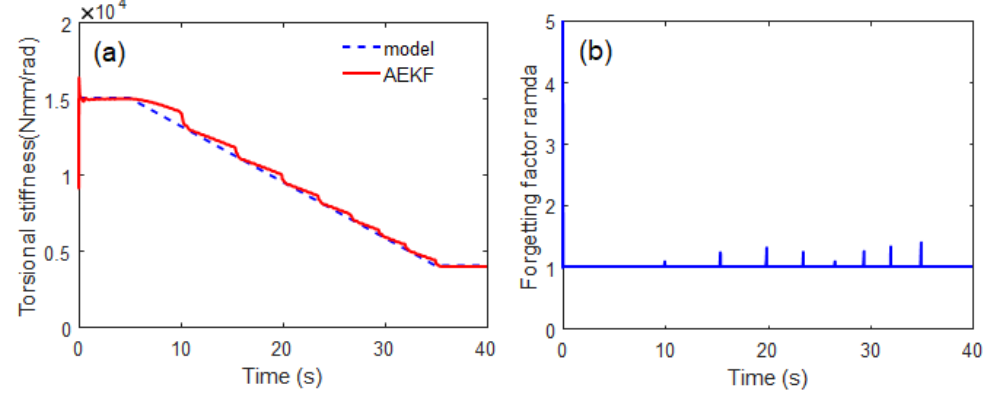
Figure 6. Simulation result for tracking gradual torsional stiffness drop for 30 s: ( a ) time response of torsional stiffness, ( b ) corresponding time history of forgetting factor.